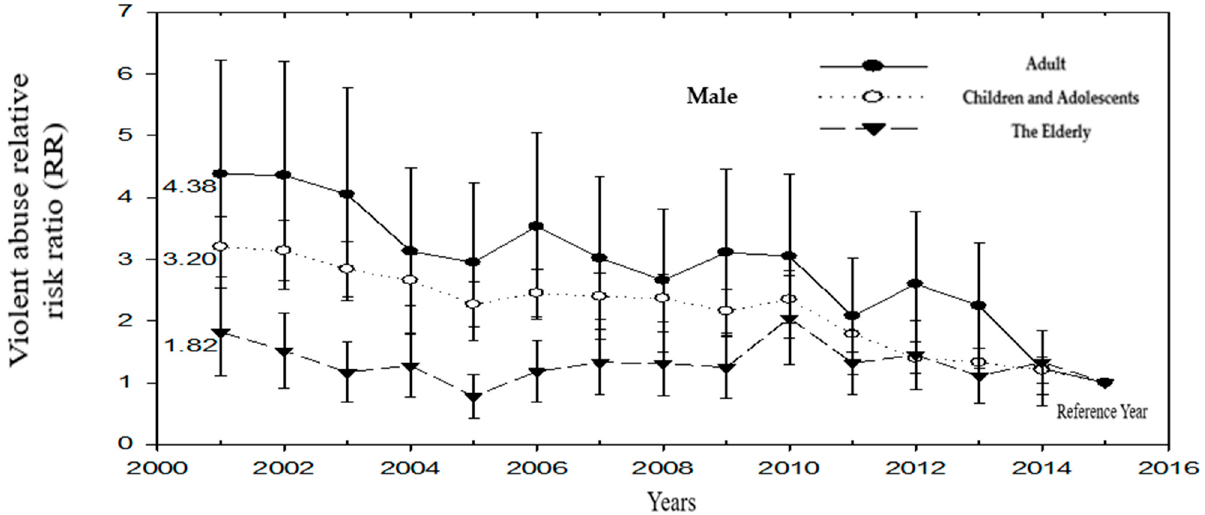
Figure 4. The relative hazard ratio (RR) of seeking medical treatment for violence in children, adults, and the elderly over the years (Male) (Reference group: 2015).